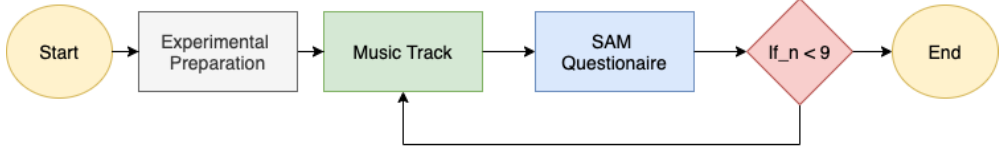
Figure 1. Flowchart of the experimental